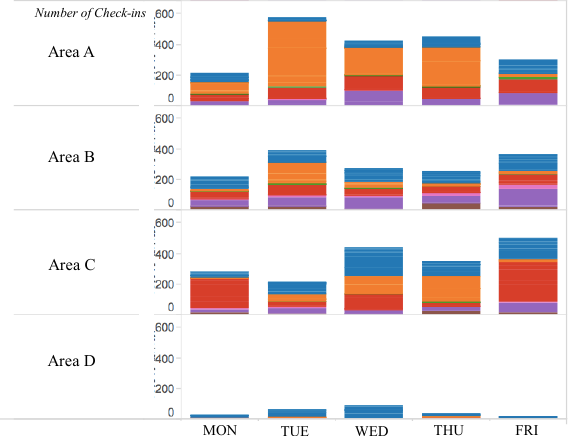
Figure 6. Usage frequency analysis by the day of week 4.3.3 Spider graph of worker movement: Figure 7 shows the worker movements on a floor map. All movement from each area to destination is indicated by a line. Although a spider graph is often utilized to evaluate commercial zones in marketing, we utilized the spider graph to visualize movement tendencies and range. The upper side of Figure 7 shows the movement of Sector A, and the lower side shows Sector B. This output shows that the movement in Sector B tends to occur on the right side of the